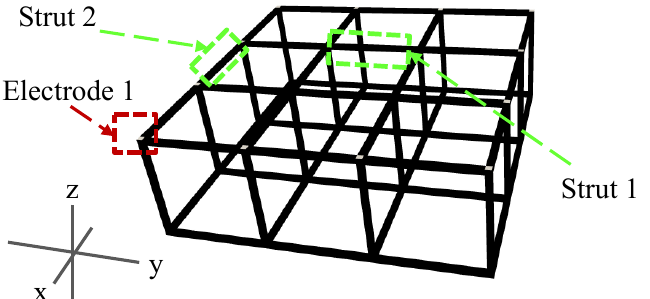
Figure 4. A 3 × 3 × 1 lattice structure model was created in Abaqus. Electrodes in the upper z-plane are marked in white.